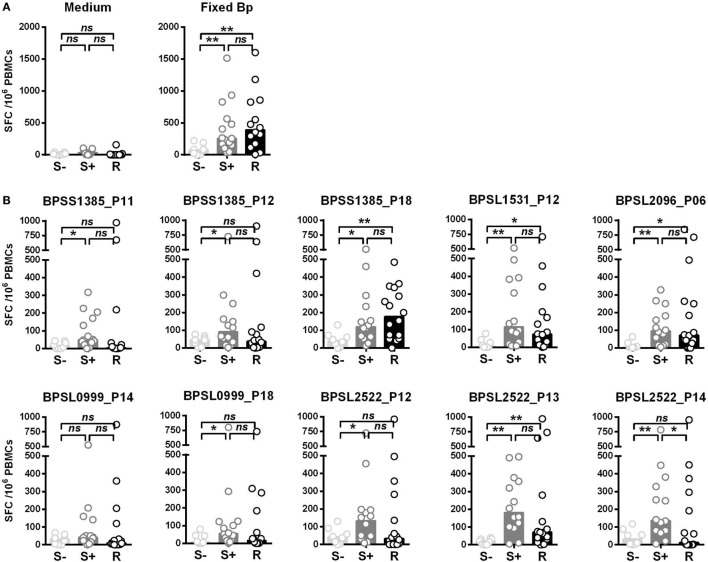
Differential IFNγ responses to 10 Burkholderia pseudomallei (Bp) immunoprevalent peptides in individuals that are seronegative for Bp, seropositive for Bp, or have recovered from acute melioidosis. Peripheral mononuclear cells (PBMCs) from seronegative (S−, n = 8), seropositive (S+ , n = 15), and individuals that have recovered from melioidosis (R, n = 15) were cultured with medium only control or paraformaldehyde (PFA) fixed Bp (A), or the top 10 immunoprevalent peptides (B). Horizontal lines represent mean value for each group. Statistical significance was determined using Mann–Whitney U test; ns, not significant, * p < 0.05 and ** p < 0.01.